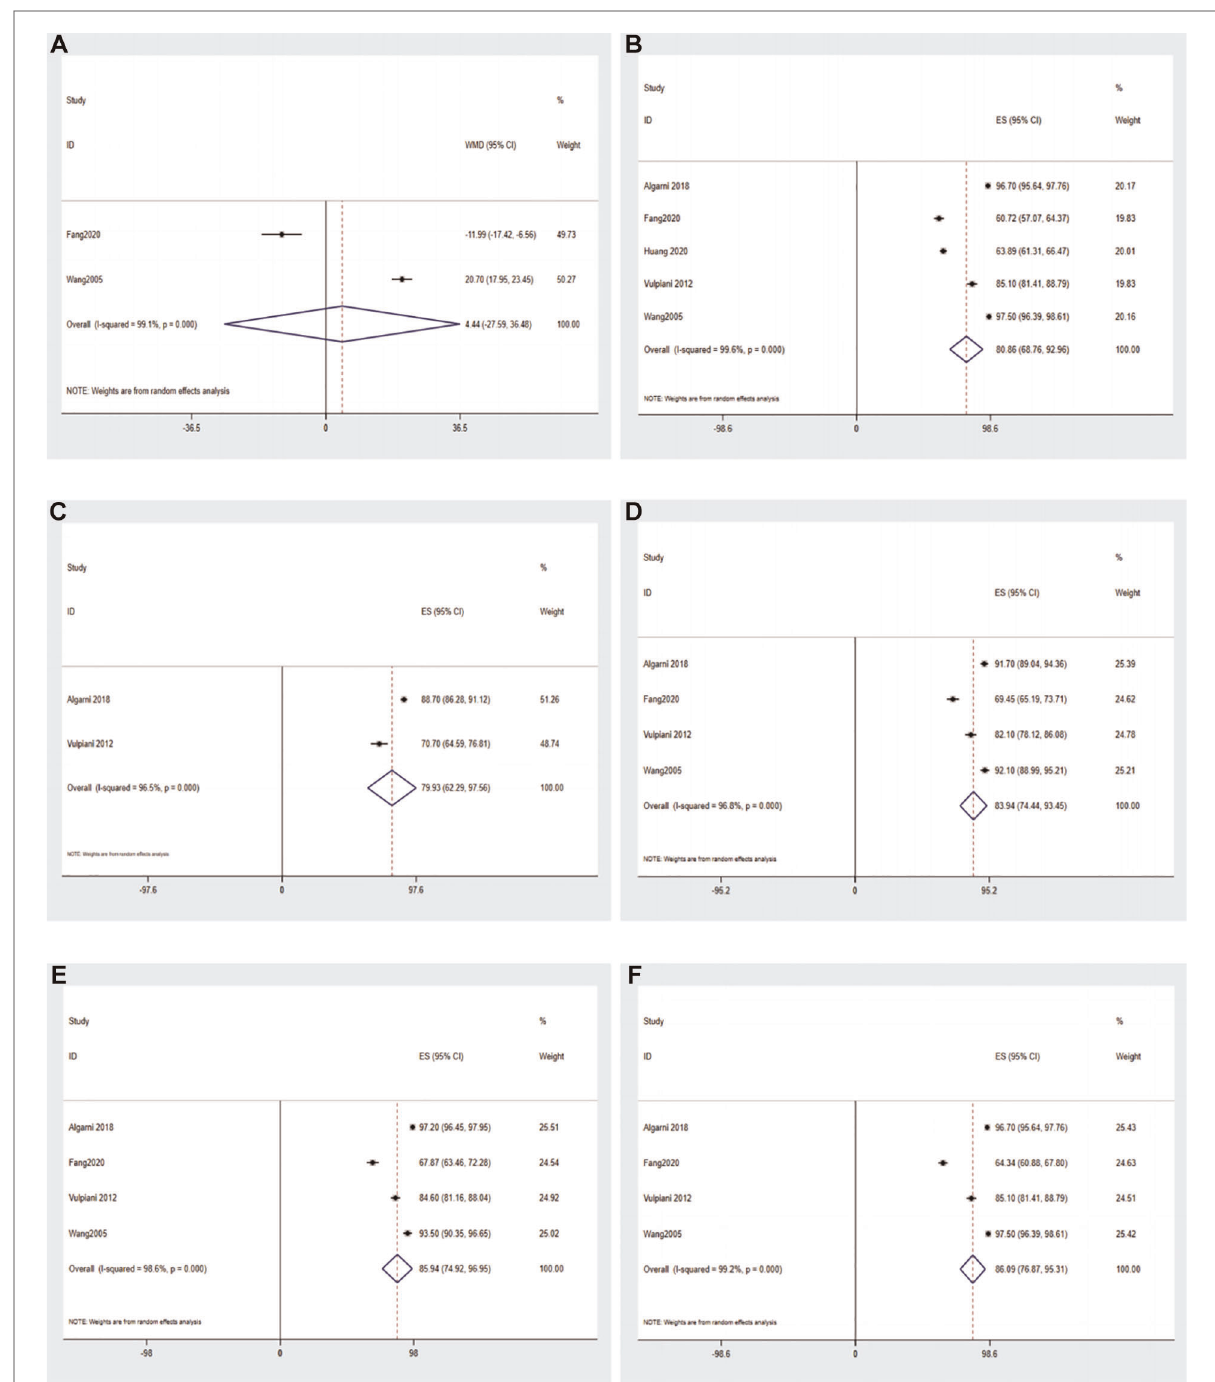
FIGURE 5 The forest plot of HHS. ( A ) The forest plot of the random effects model for 2 comparative studies; ( B ) the forest plot of the random effects model for a single-arm meta-analysis of 5 studies; ( C ) the forest plot of the random effects model for a single-arm meta-analysis of 2 studies at 3-month follow- up; ( D ) the forest plot of the random effects model for a single-arm meta-analysis of 4 studies at 6-month follow-up; ( E ) the forest plot of the random effects model for a single-arm meta-analysis of 4 studies at 12-month follow-up; ( F ) the forest plot of the random effects model for a single-arm meta-analysis of 4 studies at 24-month